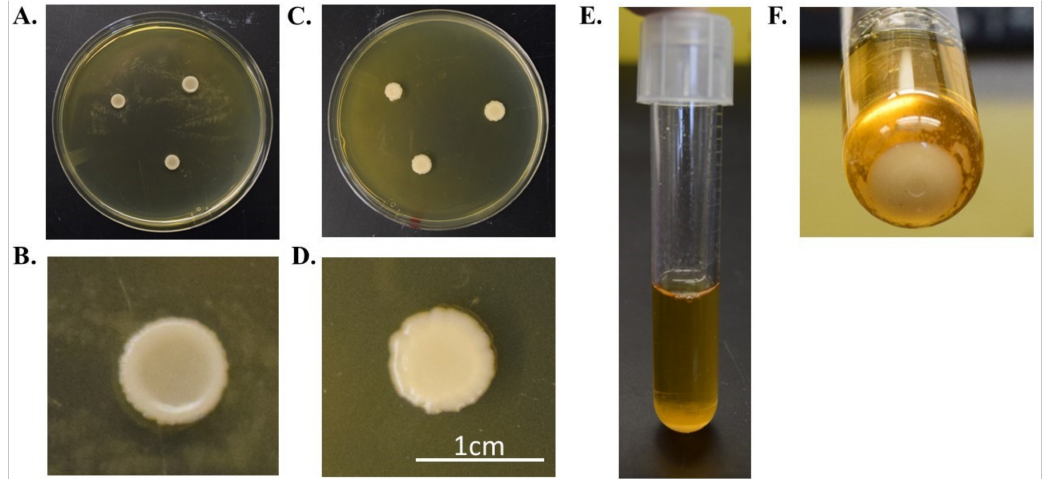
Figure 1. Morphology of Kazachstania slooffiae . K. slooffiae was grown for 24 h on Yeast Potato Dextrose Agar (YPD) ( A ) and Sabouraud Dextrose (SD) ( C ) agars. Individual colony morphology on YPD demonstrates concave growth ( B ) and SD demonstrated flat colony growth ( D ). Growth in 5 mL YPD broth ( E , F ).